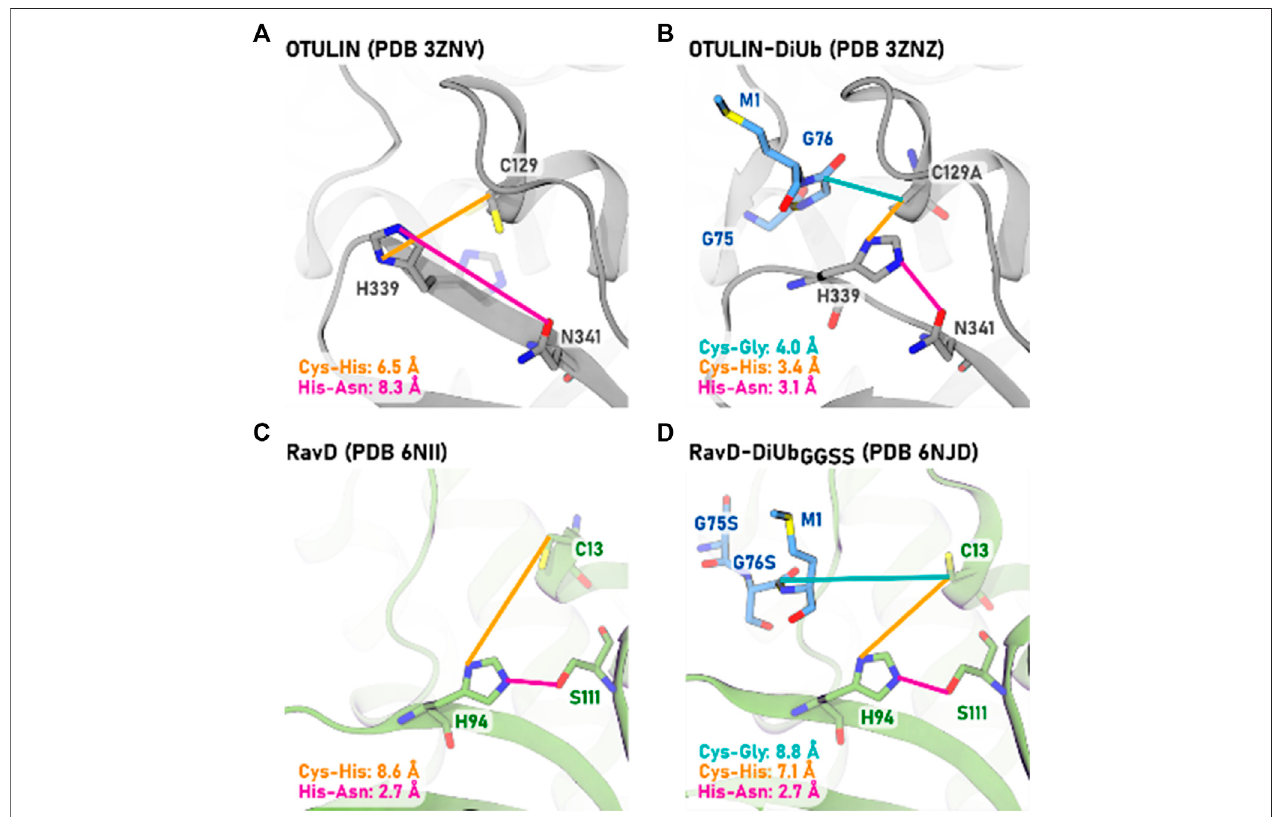
FIGURE1 | Comparison of structural parameters ofcatalytic triad residues inmethionine 1-speci fi cDUBs OTULIN [ (A,B) , gray] and RavD [ (C,D) , green]. The apo- protein structures (A,C) are compared to the protein-protein structures when in complex with their di-ubiquitin substrate (B,D) . The PDB entries are given in brackets. The distances to cysteine are measured from the residue ’ s C β atom for reasons of comparability with the OTULIN-diubiquitin crystal structure in which cysteine was mutatedtoalanine(C129A).Forapo-OTULIN,analternativeconformationofHis339withloweroccupancyisalsopresent(shownintransparent),whichisidentical to the conformation of His339 in OTULIN-DiUb